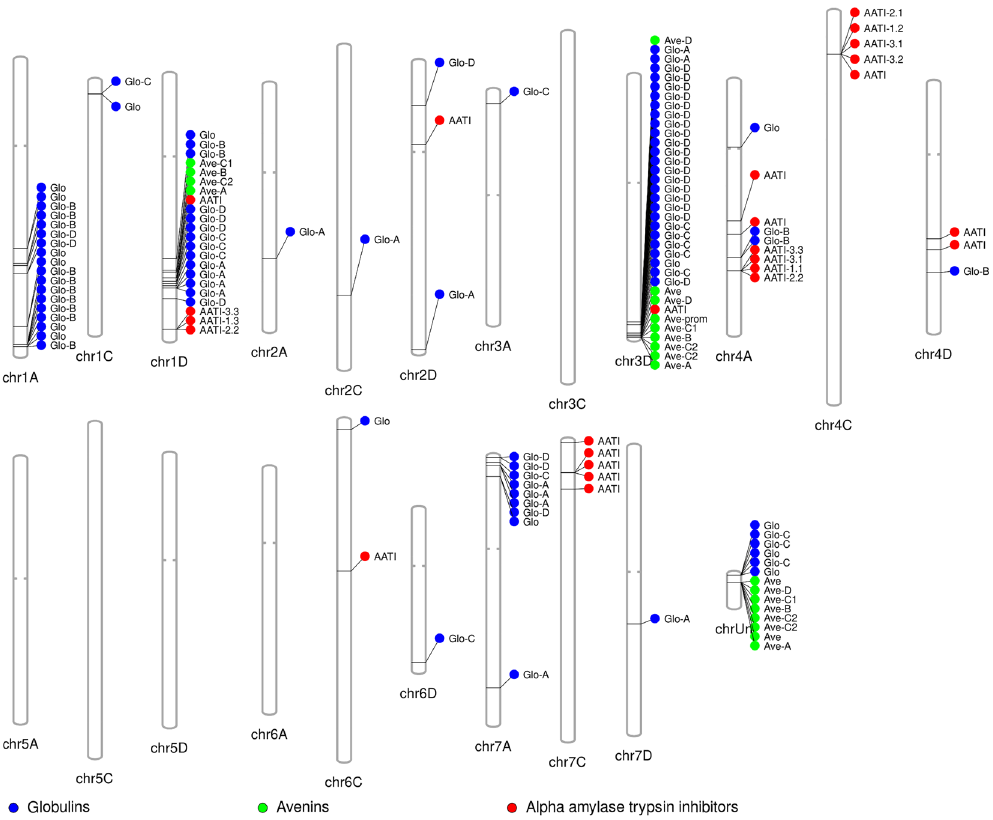
Figure 1. Avenin, globulin and AATI loci in Avena sativa chromosomes (AACCDD, 2n = 6x = 42) The figure was drawn using PhenoGram software (http:// visua lizat ion. ritch ielab. psu. edu; 38